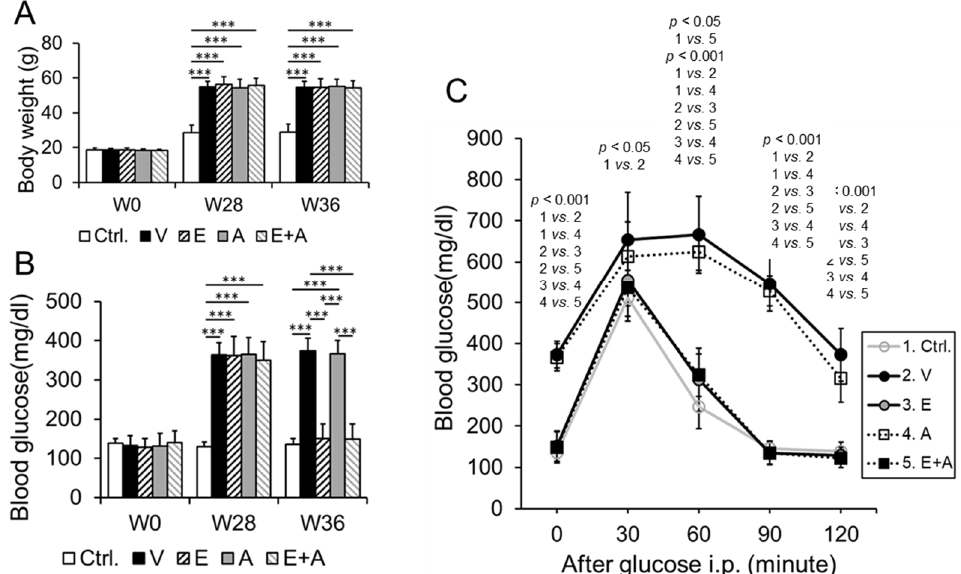
Figure 1. Changes in body weight gain, hyperglycemia and glucose intolerance in diabetic ALDH2*2 mutant mice. Body weight ( A ), blood glucose ( B ) and blood glucose tolerance ( C ) data were shown from non-diabetic control ALDH2*2 mutant mice (Ctrl.), vehicle-treated ALDH2*2 mutant diabetic mice (V), EMP-treated ALDH2*2 mutant diabetic mice (E), Alda-1-treated ALDH2*2 mutant diabetic mice (A) and EMP + Alda-1-treated ALDH2*2 mutant diabetic mice (E + A). Data are presented as mean ± standard error of the mean (SEM). n = 8 of each group. Weeks 0, 28 and 36 were denoted as W0, W28 and W36, respectively. In Figure 1A, *** p < 0.001 vs. Ctrl.; In ( B ), *** p < 0.001 vs. Ctrl., E and A.